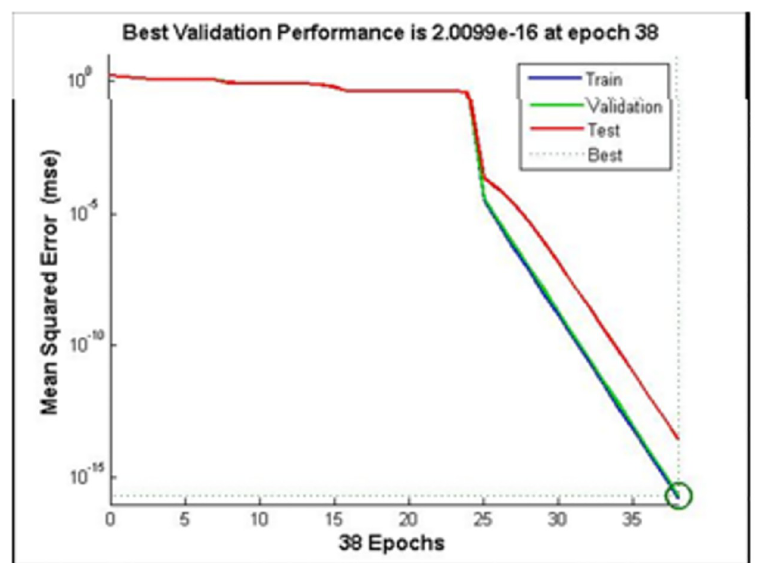
Fig 8. Training performance of DNN—MSE.